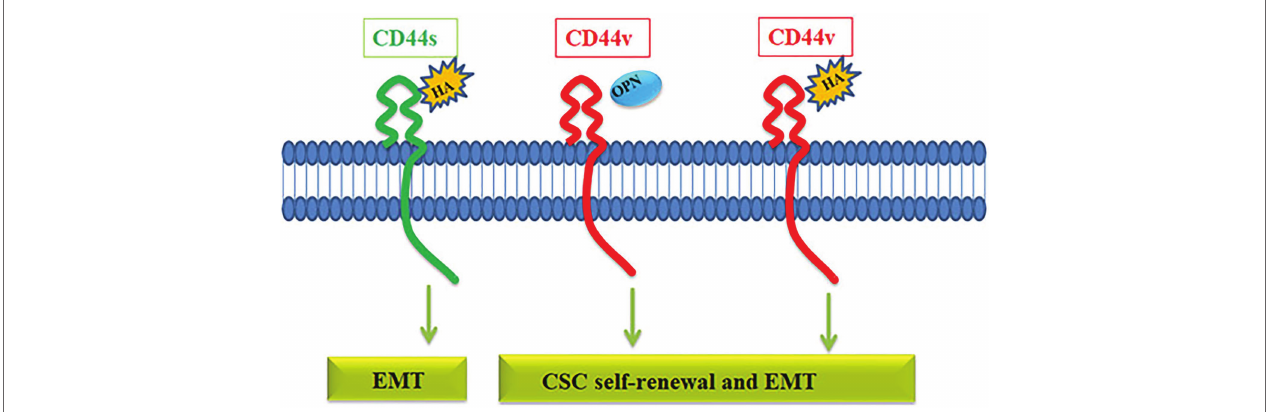
FIGURE 4 | The role of CD44 in the regulation of CSC properties. The CD44 gene gives rise to CD44s variant or CD44v variant. CD44s interacts with hyaluronic acid (HA) activating pathways that induce EMT. HA can also bind to CD44v receptor and activate EMT and self-renewal through various pathways. Another ligand osteopontin (OPN) binds specifically to CD44v, which induces EMT and